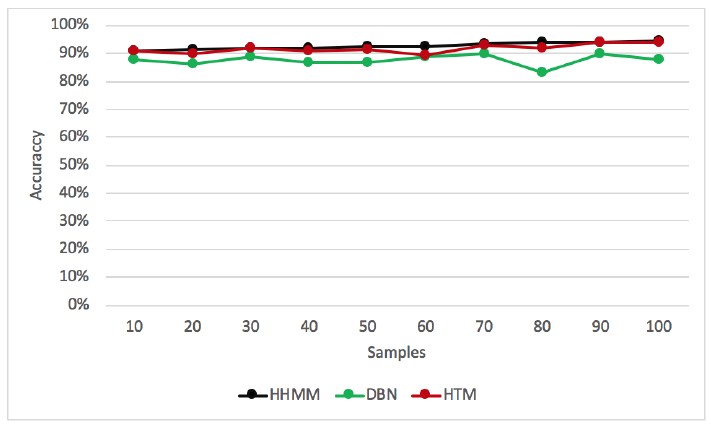
Figure 10. Accuracy of anomaly root cause identification.